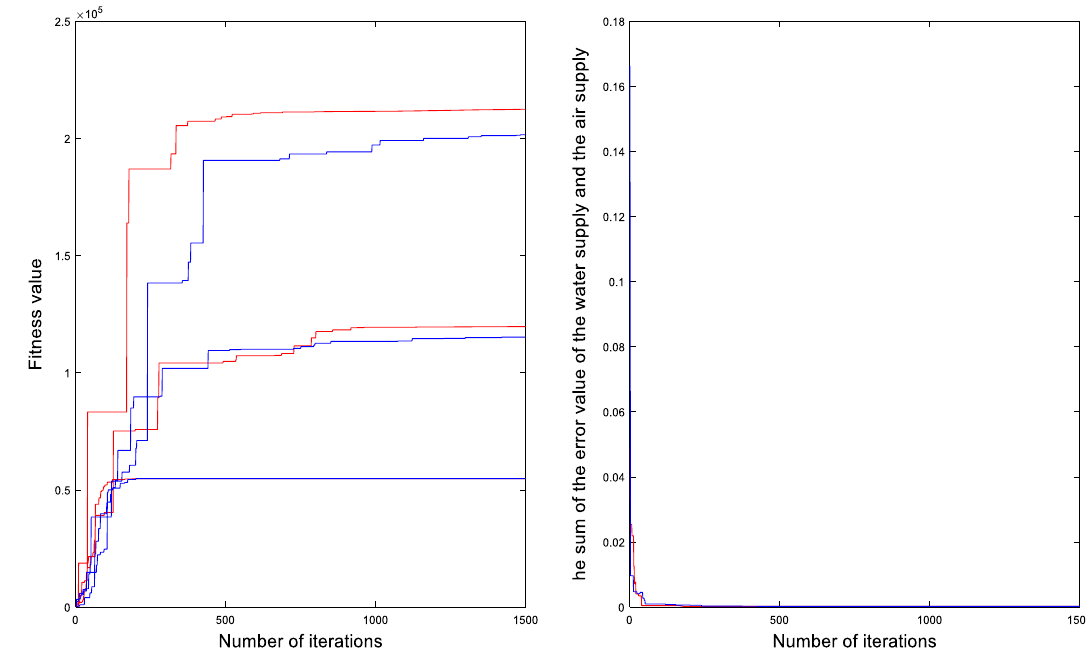
Fig. 6 The search process of the optimal operation